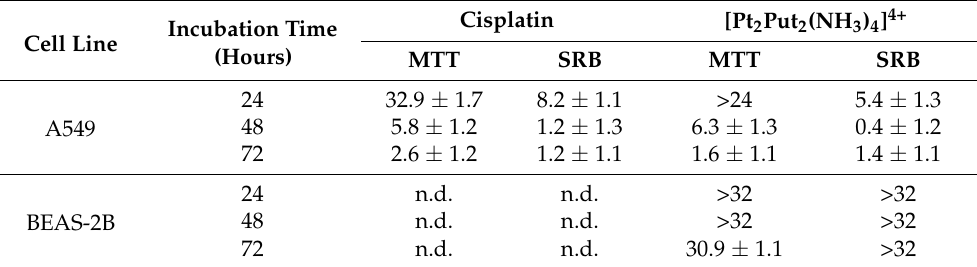
Figure 2. Dose–response curves for cisplatin and [Pt 2 Put 2 (NH 3 ) 4 ] 4+ against the A549 human lung cancer cell line, at 24, 48 and 72 h incubation times. Data are expressed as mean ± standard error of the mean (SEM), n = 4. Table 1. Half maximal inhibitory concentration (IC 50 , µ M) of cisplatin and [Pt 2 Put 2 (NH 3 ) 4 ] 4+ against the A549 human lung cancer and the BEAS-2B human lung non-cancer cell lines, at 24, 48 and 72 h incubation